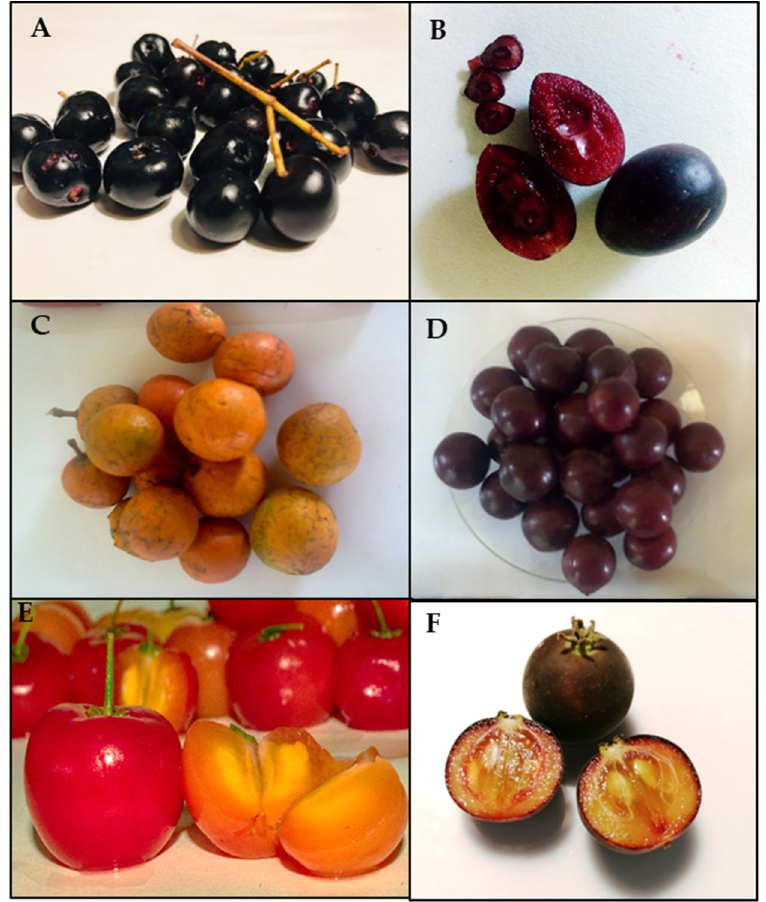
Figure 1. Fruits of each species used in the study: ( A ) Màdan ( Syzygium cumini ), ( B ) Maha karamba ( Carissa carandas ), ( C ) Himbutu ( Salacia chinensis ), ( D ) Ugurassa ( Flacourtia indica ), ( E ) Barbados cherry ( Malpighia emarginata ), ( F ) Ceylon gooseberry ( Dovyalis hebecarpa ).